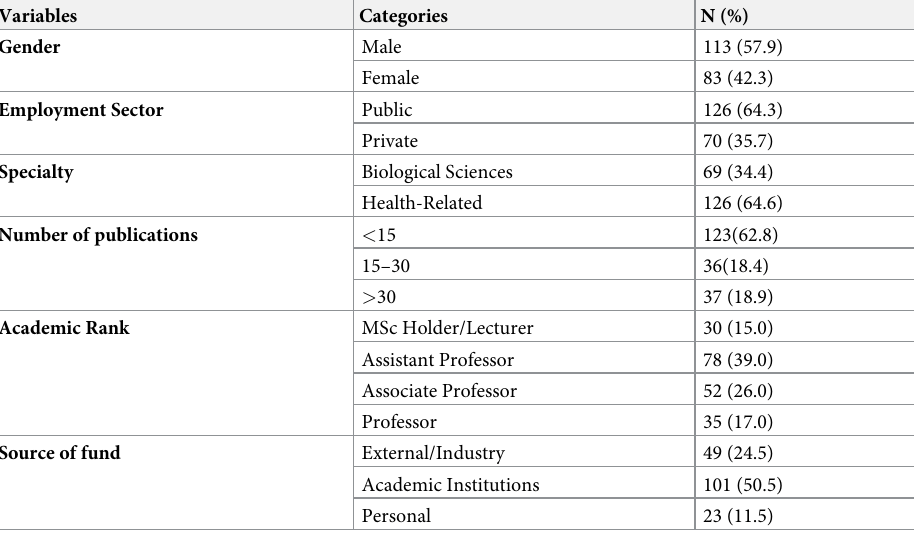
Table 1. Demographic data of the respondent researchers (N =